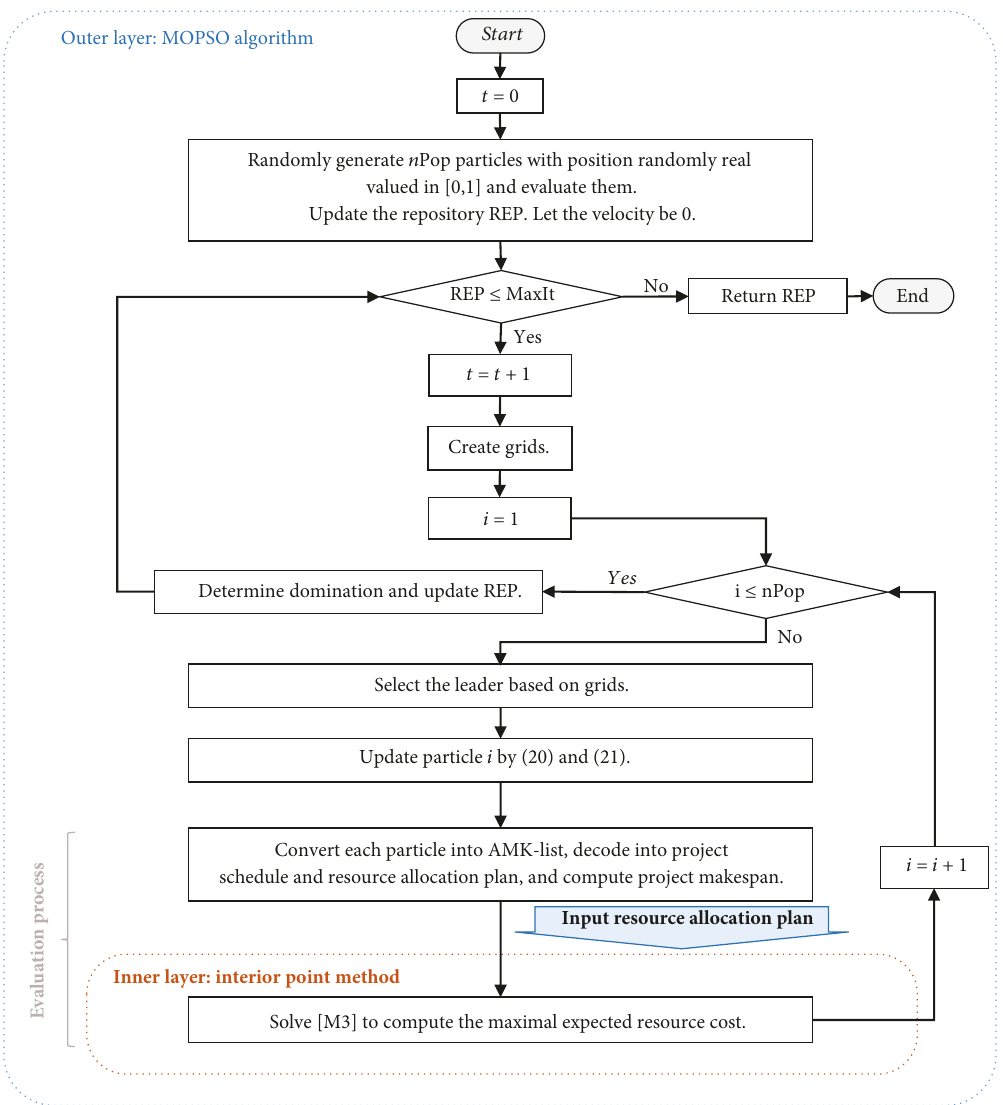
Figure 3: Flowchart of MOPSO-interior point